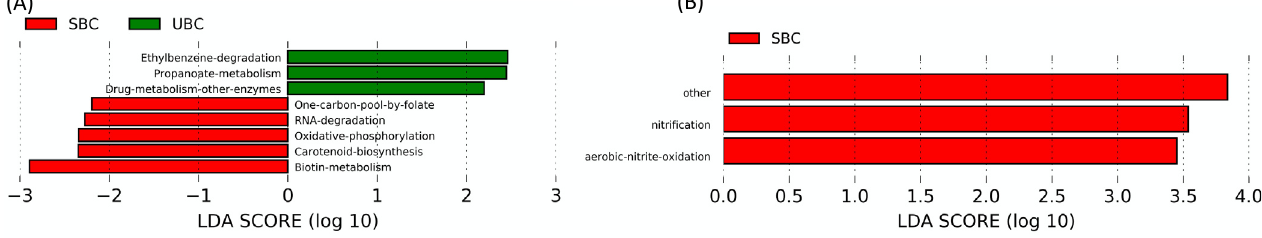
Figure 6. Differential abundance of predicted functions between SBC and UBC treated soil. LEFSe analysis of PICRUSt2 ( A ) and FAPROTAX ( B ) predicted functions in SBC and UBC treated soil among no-plant samples and plant samples, respectively.